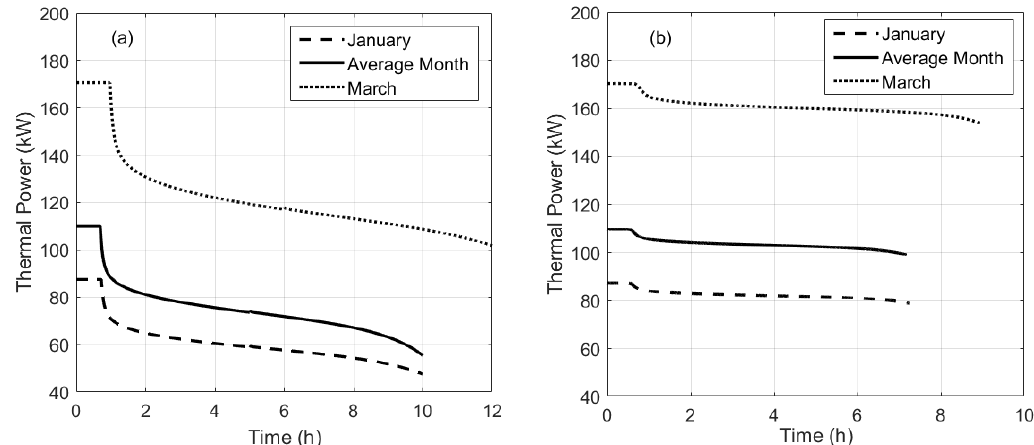
Figure 7. Thermal power transferred to and released by the TES system during ( a ) charge and ( b ) discharge phases.